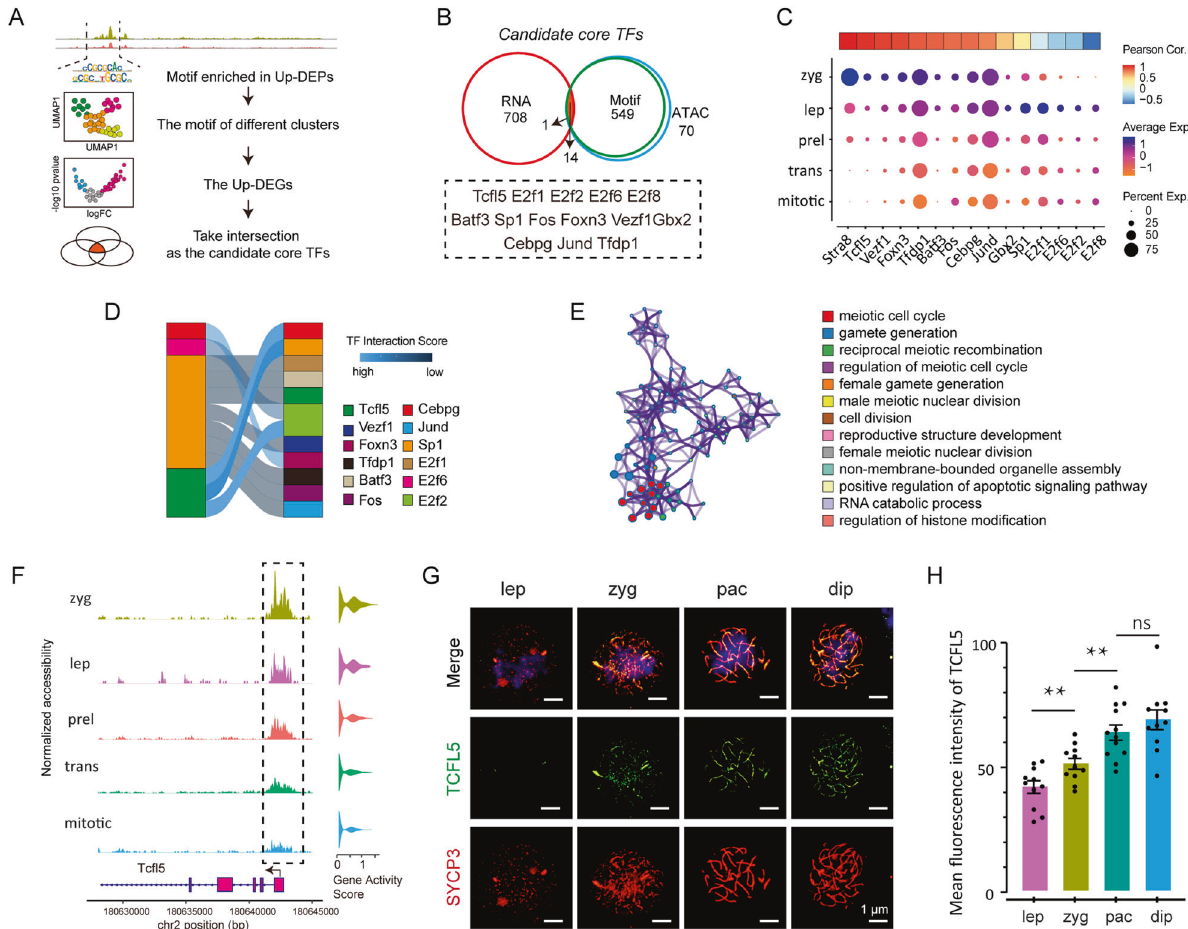
Fig. 5 Identi fi cation of TFs in female germ cells associated with mitotic/meiotic switch. A Work fl ow of the selected framework of potential core TFs in meiotic initiation. B Final acquired core TFs of meiotic initiation. C Dot plot shows the expression trend of fi nal acquired potential core TFs. The upper panel shows Pearson ’ s correlation between core TFs and Stra8 . D Sankey diagram of TFs interaction network; Blue represents strong interactions, black represents weak interactions. E Function enrichment network of TCFL5 potential bound genes. F The epigenetic characteristics of Tc fl 5 ; Volcano plot shows the gene activity score of Stra8 in cell subtypes. G TCFL5 immunolocalization on chromosomes of germ cells at different stages of meiotic prophase I; bar = 1 μ m, n ≥ 11; Red shows SYCP3, green showsTCFL5, and blue shows nuclei; H The barplot showing the expression level of TCFL5 protein at different stages of meiotic prophase I. ** means p value < 0.01. mitotic mitotic subtypes, trans transition-phase subtypes, prel preleptotene subtypes, lep leptotene subtypes, zyg zygotene subtype, pac pachytene subtype, dip diplotene